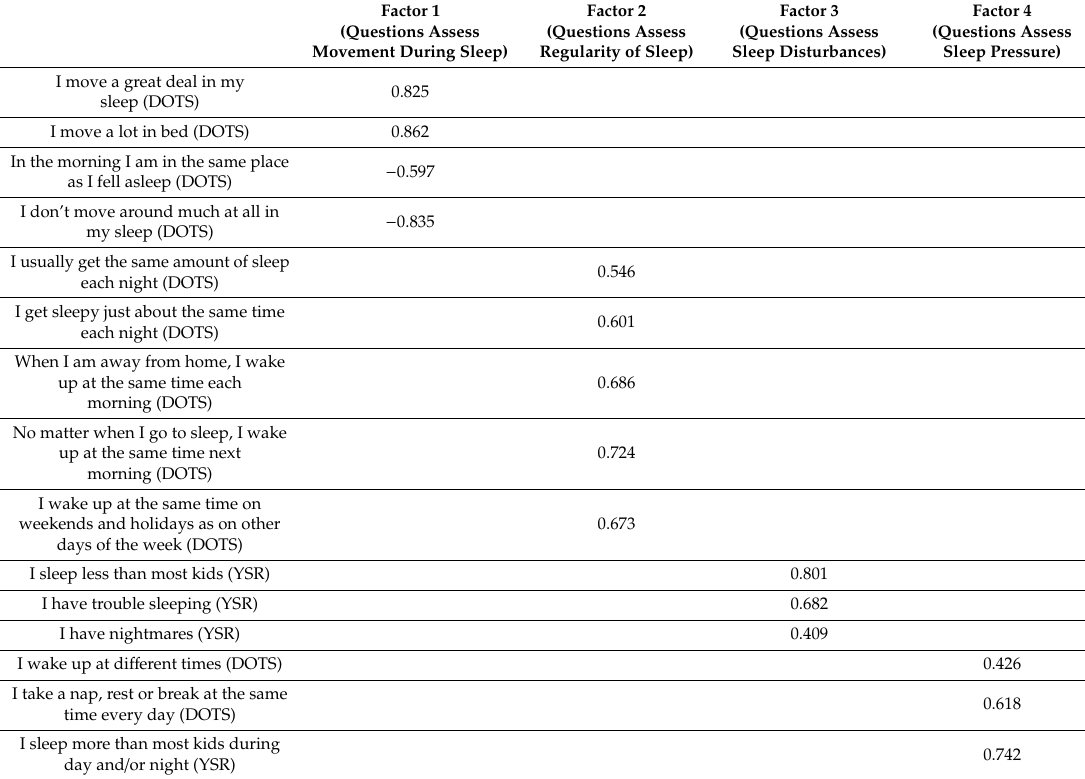
Table 2. Principal Component Analysis of sleep